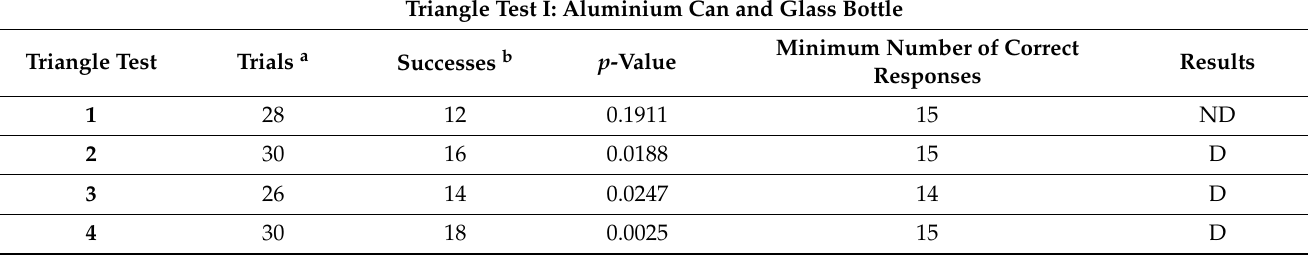
Table 2. Results from the Triangle Olfactometric Test I with α ≤ 0.05.